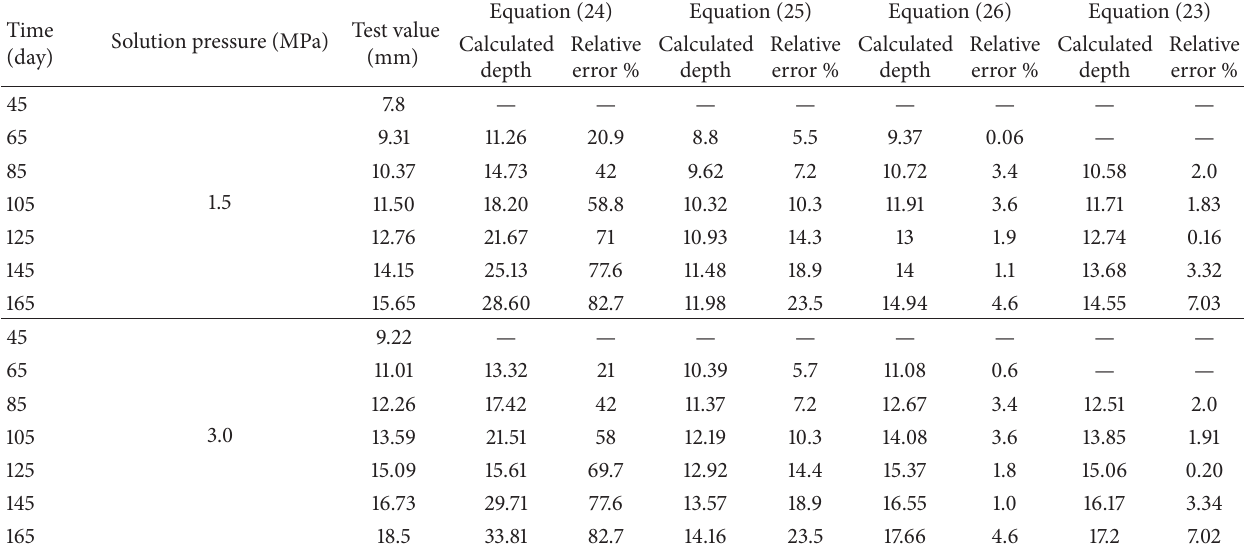
Table 6: Diffusion depth values calculated by various models (mm).